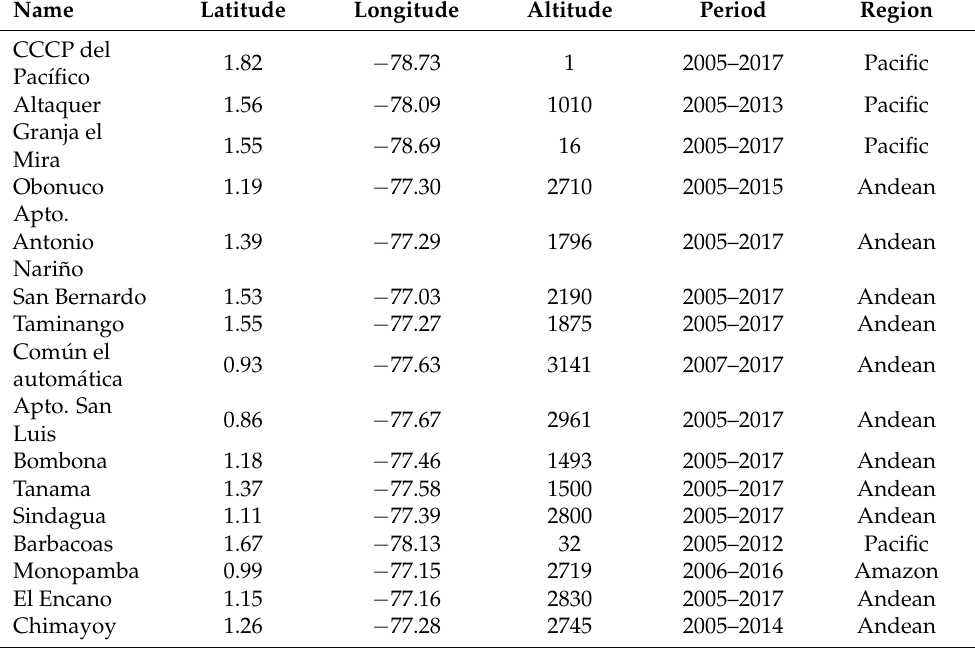
Table 2. Conventional weather stations in